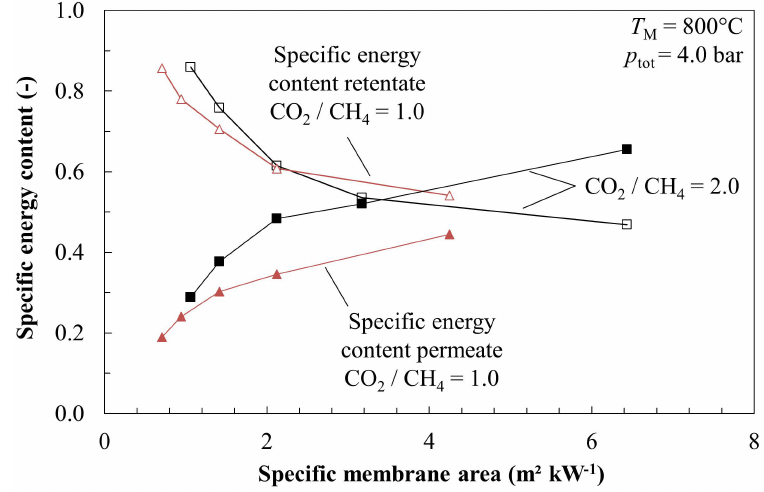
Figure 7. Specific energy content of permeate and retentate for membrane dry reforming at a process temperature of 800 ◦